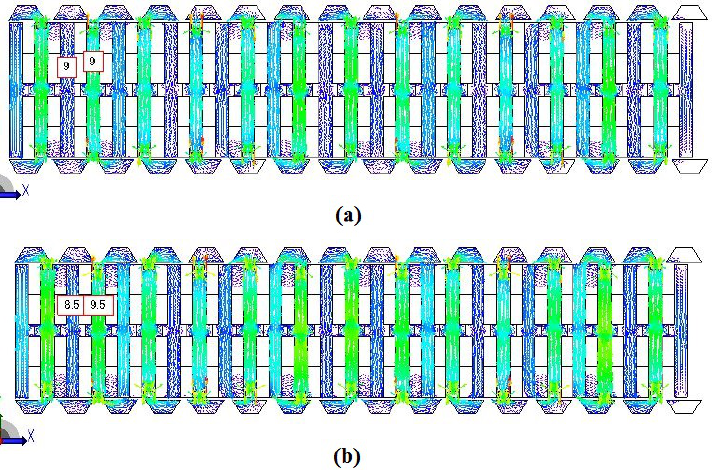
Figure 7. On-load magnetic flux lines: (a) equal primary tooth width and (b) unequal primary tooth width.